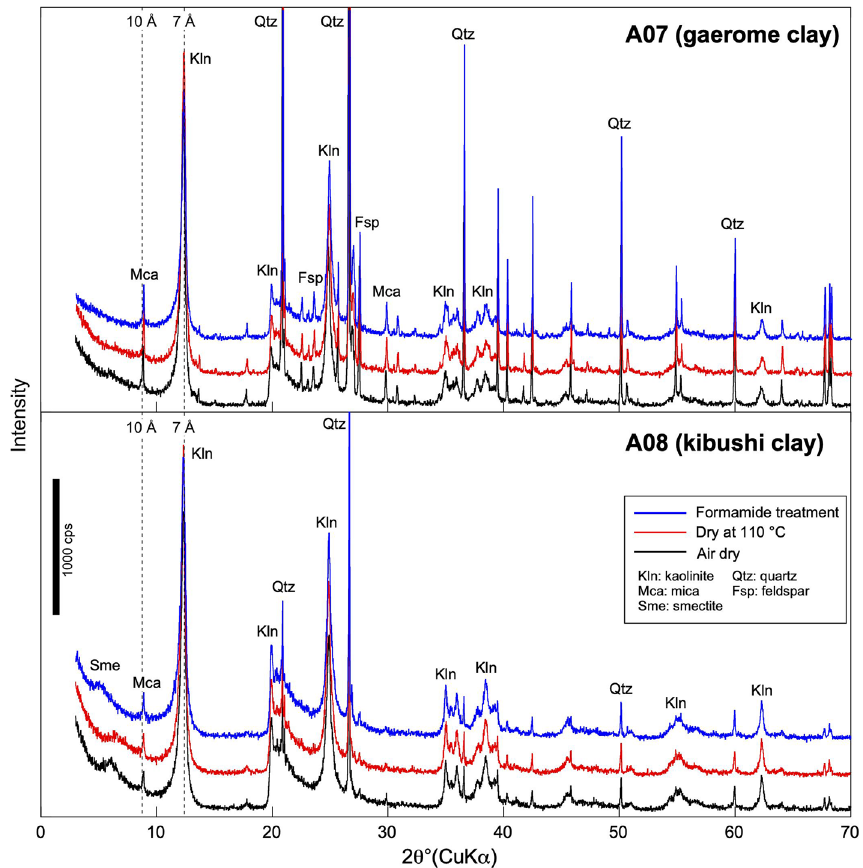
Figure 5. X-ray diffraction patterns of gaerome clay (A07) and kibushi clay (A08). The analyses were performed in the following conditions: dried in air, dried at 110 °C for 2 h, and treated with